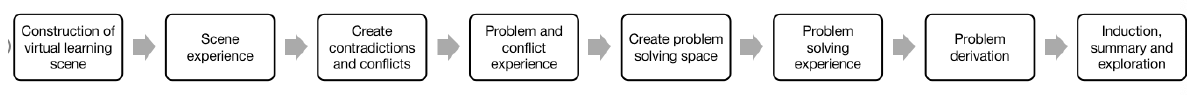
Figure 3. VR situation creation